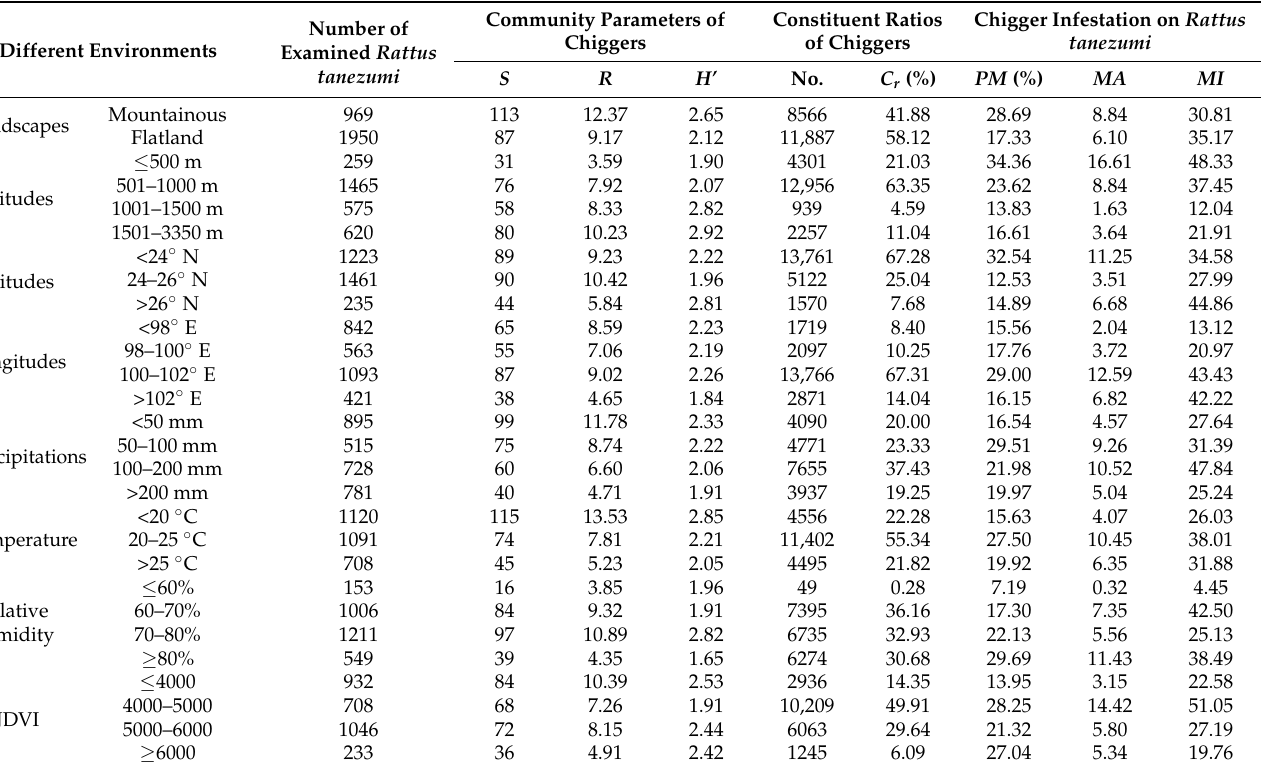
Table 2. Variations of chigger infestation on oriental house rats ( Rattus tanezumi ) in different environ- ments in 5 provincial regions of Southwest China